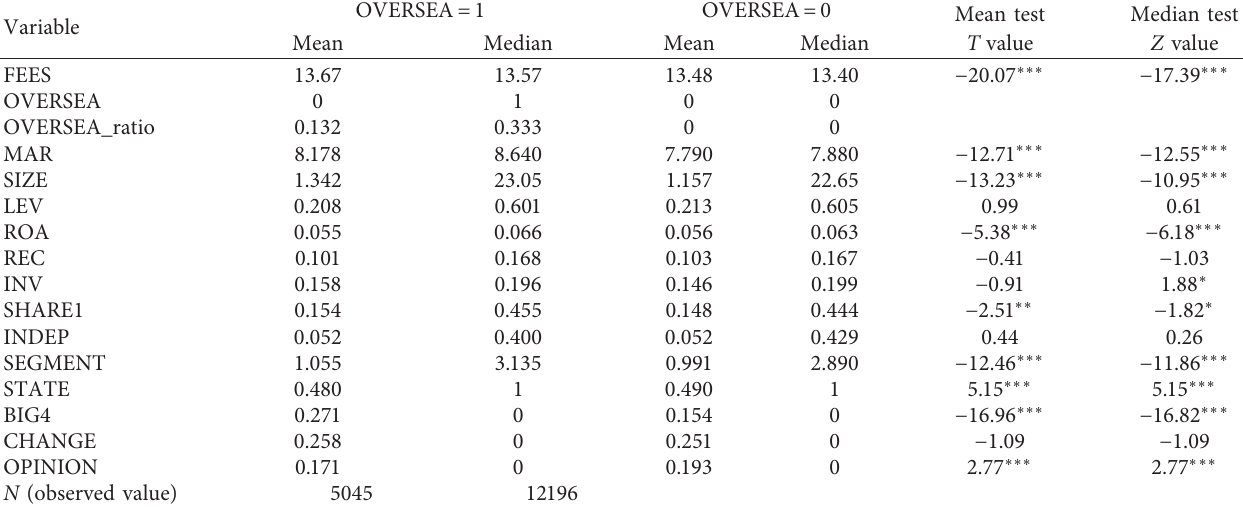
Table 3: Univariate analysis.